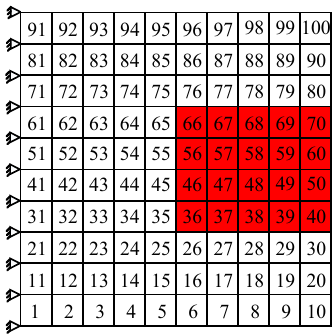
Figure 9. The damping optimization scheme for the fourth order. Table 6. Comparison between the damping optimization results for the fourth order and the results corresponding to the full coating structure.